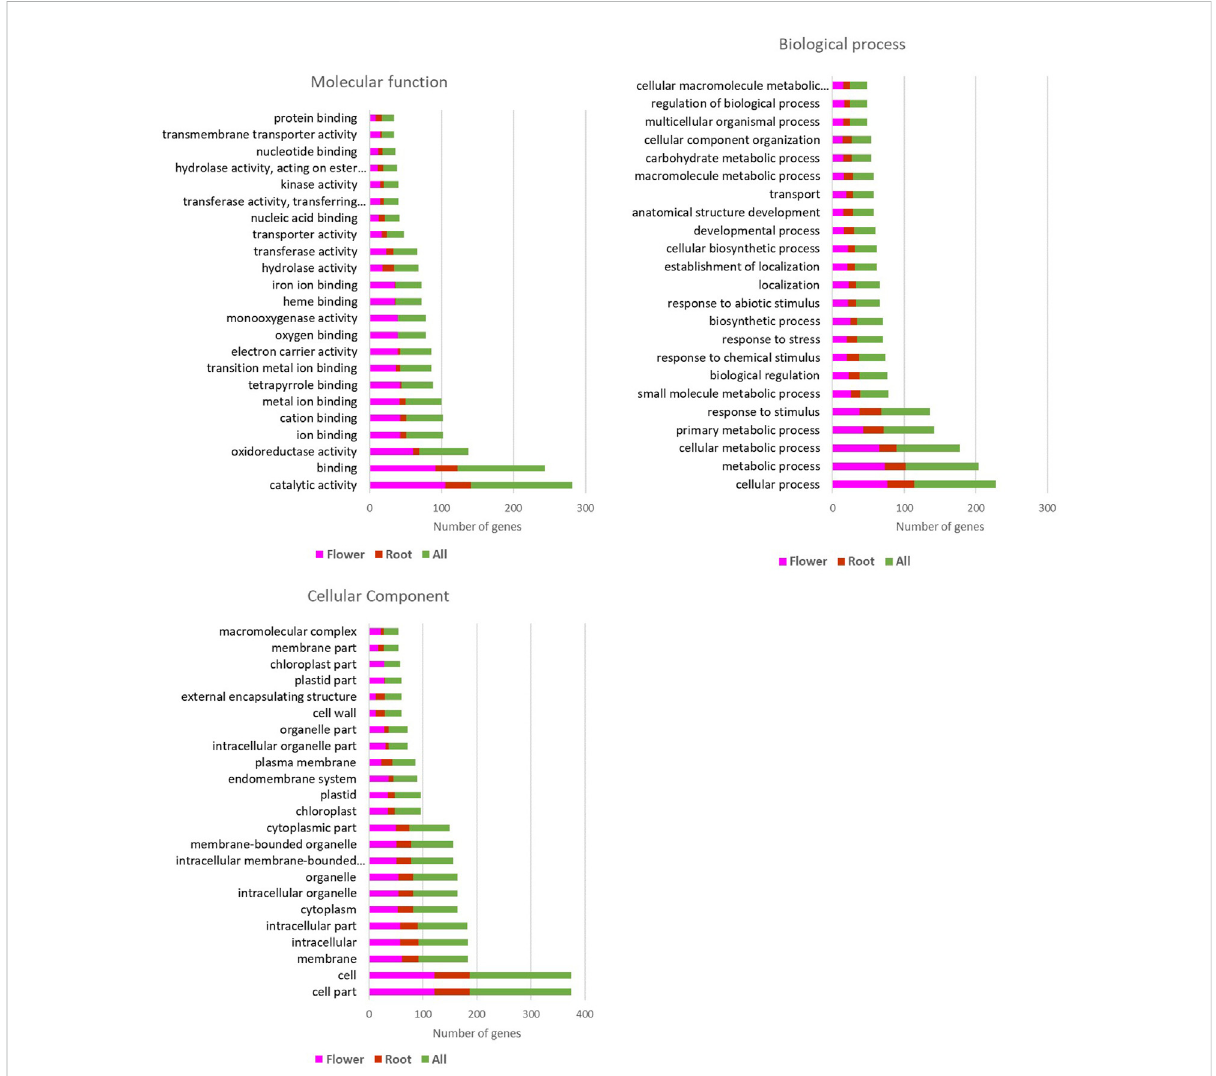
FIGURE 1 Gene ontology results of the upregulated genes in the fl ower and the root of the Oliveria decumbens